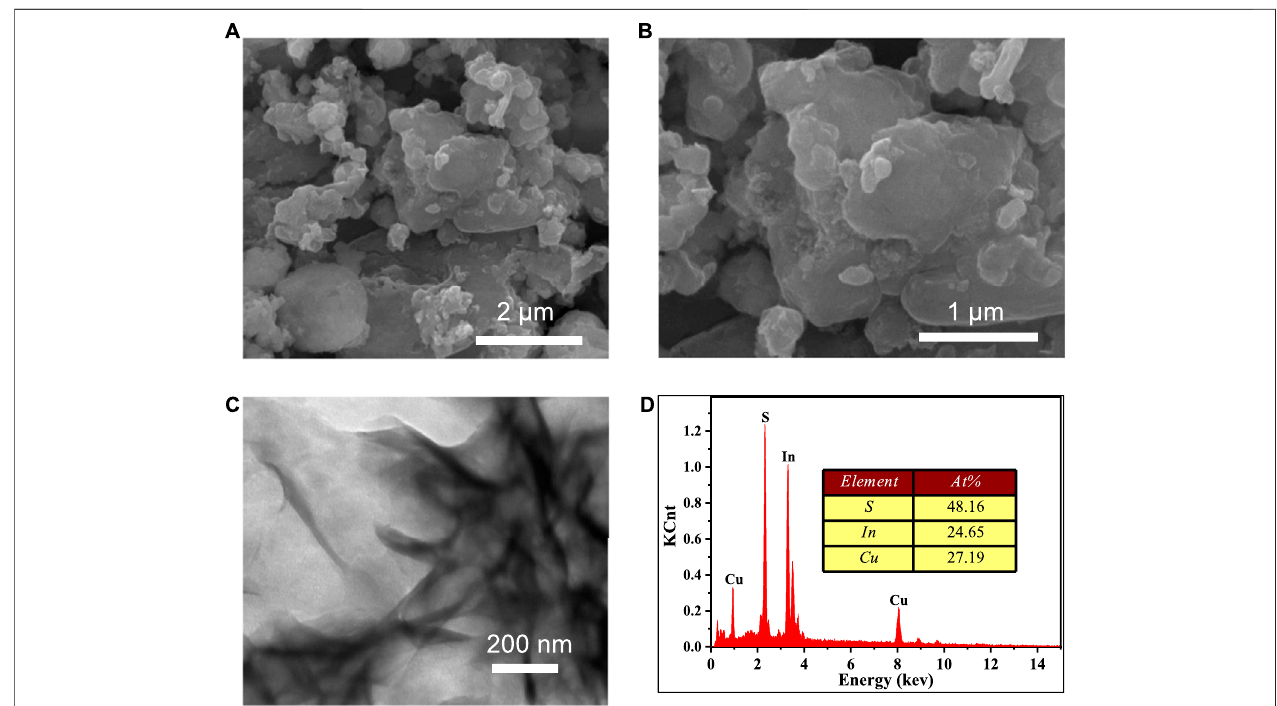
FIGURE 2 | (A,B) SEM images, (C) TEM image and (D) EDS spectrum of our synthesized CuInS 2 .